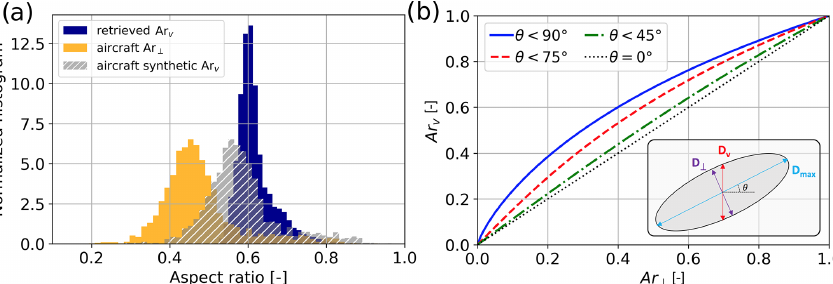
Figure 11. (a) Histogram of retrieved and aircraft-measured aspect ratio. (b) Illustration of the relation between A r , ⊥ and A r , v for particles with random orientation within a given angle θ ; the various quantities are sketched in the bottom right of panel (b) .